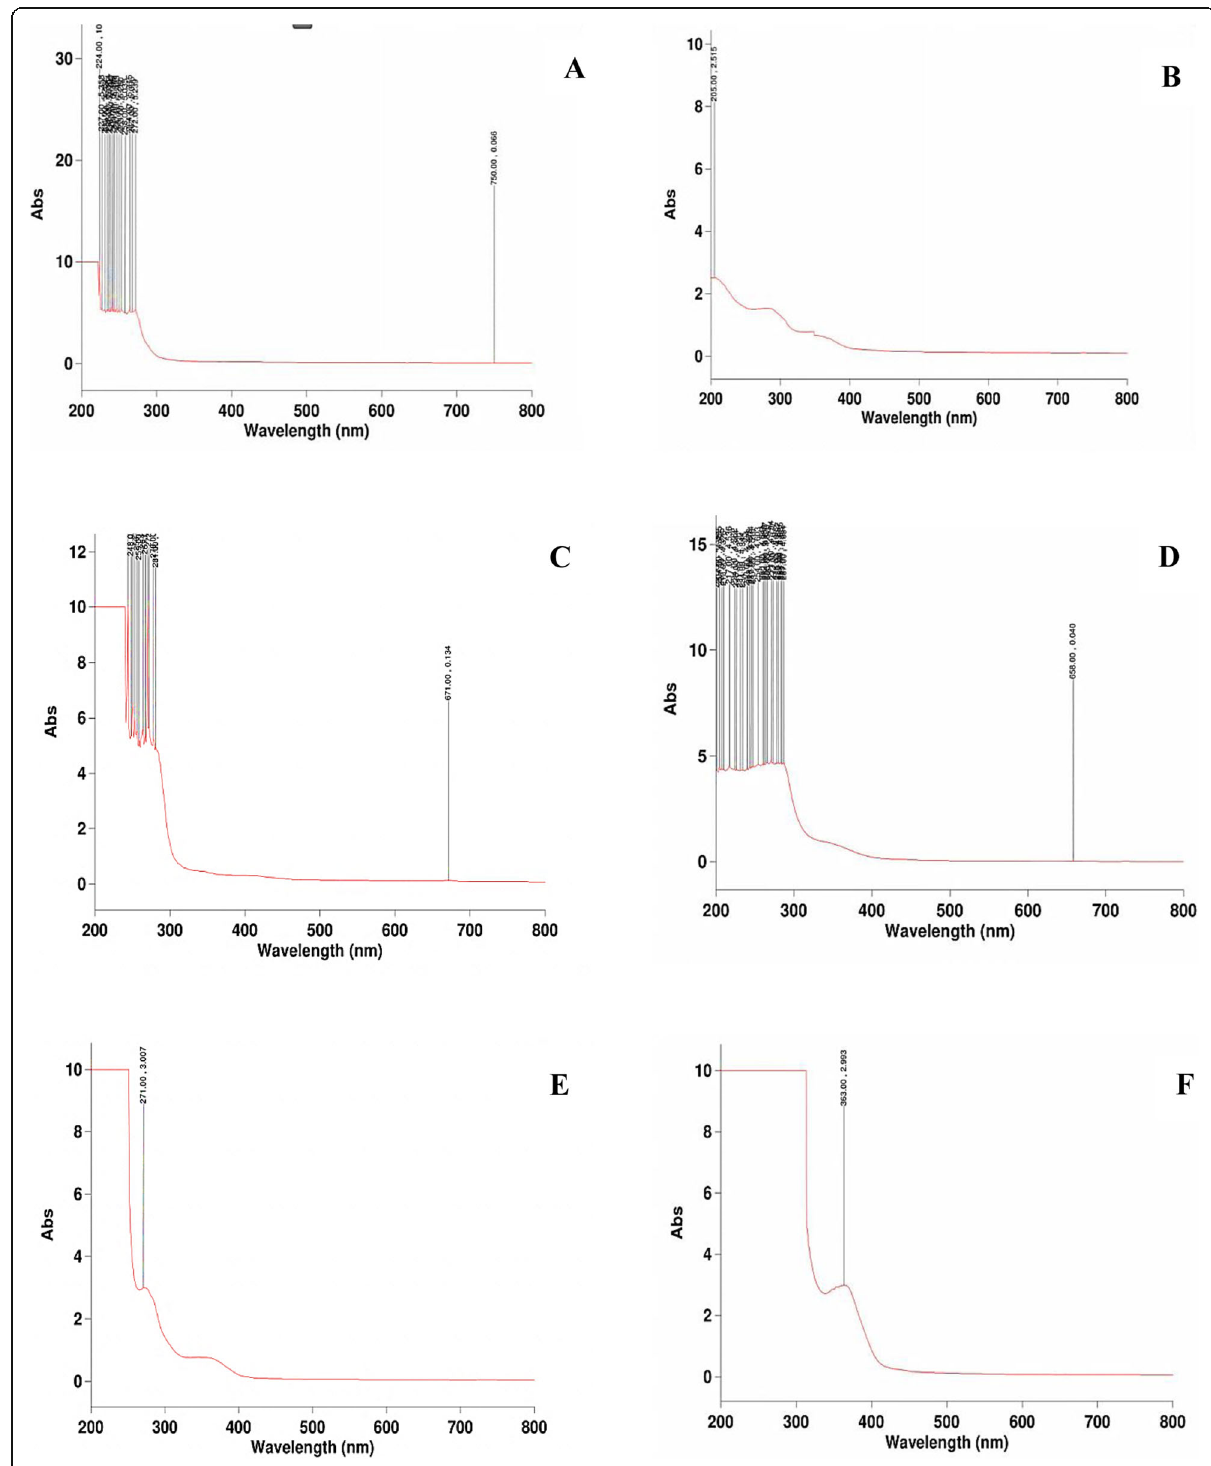
Fig. 6 UV-visible spectra. a Petroleum ether extract of A . occidentale . b Ethylacetate extract of A . occidentale . c n -Hexane extract of P . guajava . d Chloroform extract of P . guajava . e Ethylacetate extract of P . guajava . f Ethylacetate extract of T .